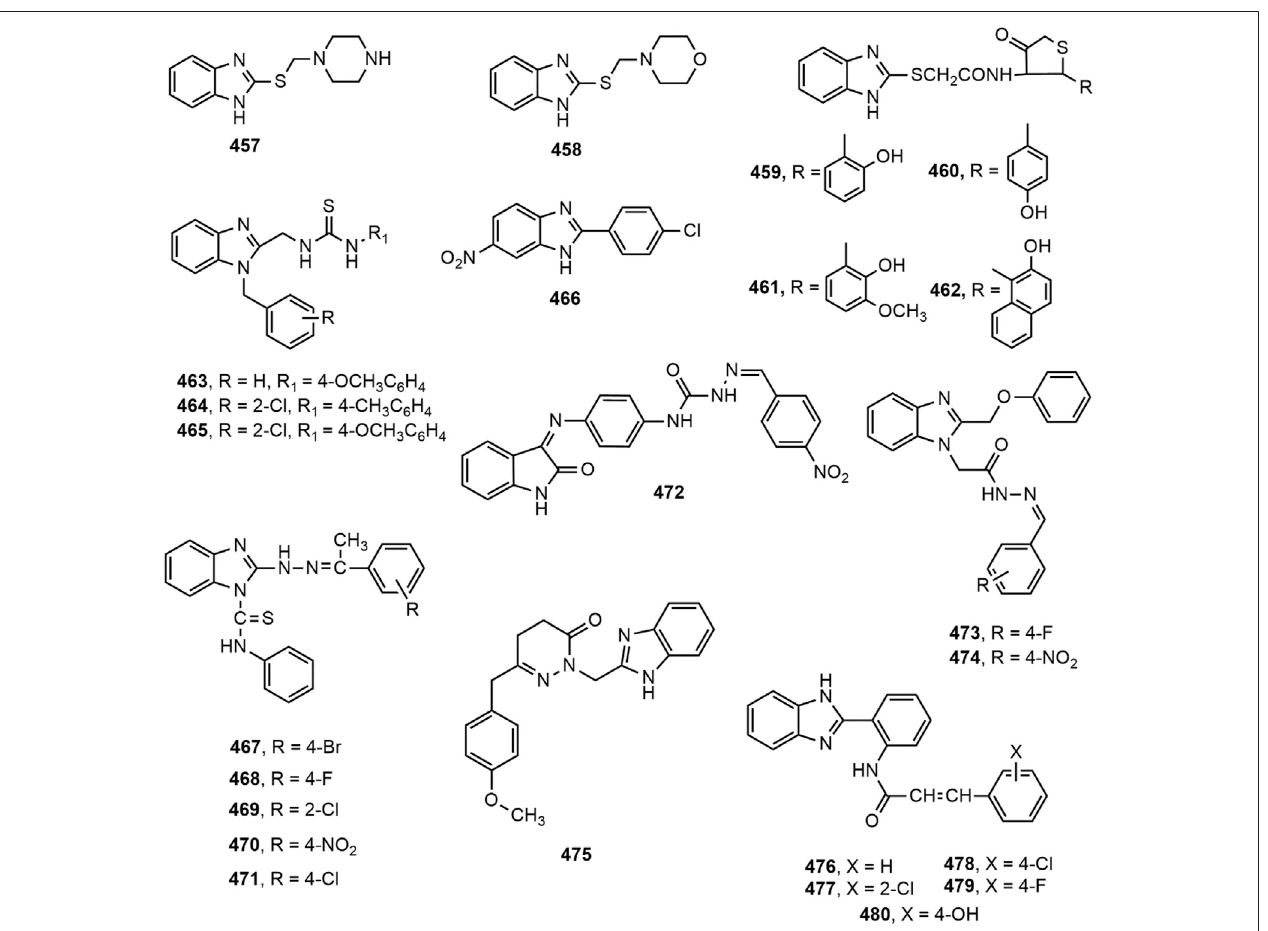
FIGURE 19 | Benzimidazole derivatives with anticonvulsant